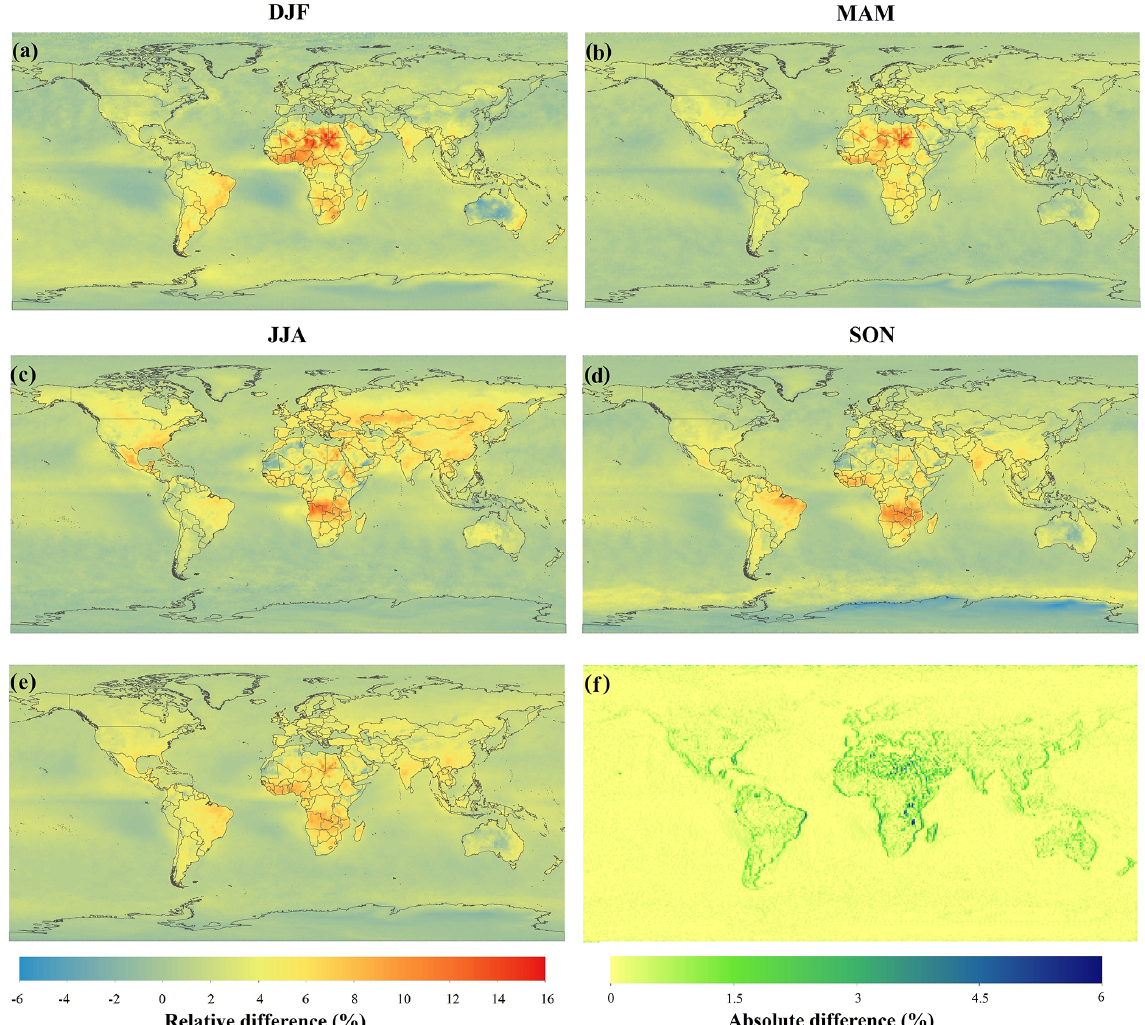
Figure 1. AIRS TCO averaged day-to-night relative difference during 2003–2018 for (a) December–January–February, (b) March–April– May, (c) June–July–August, and (d) September–October–November. (e) AIRS TCO 16-year averaged day-to-night relative difference during 2003–2018. (f) Absolute difference between two adjacent pixels at the same latitude in panel (e) . Note that the relative difference is calculated as 100 × (daytime − night-time) / daytime (in percent,